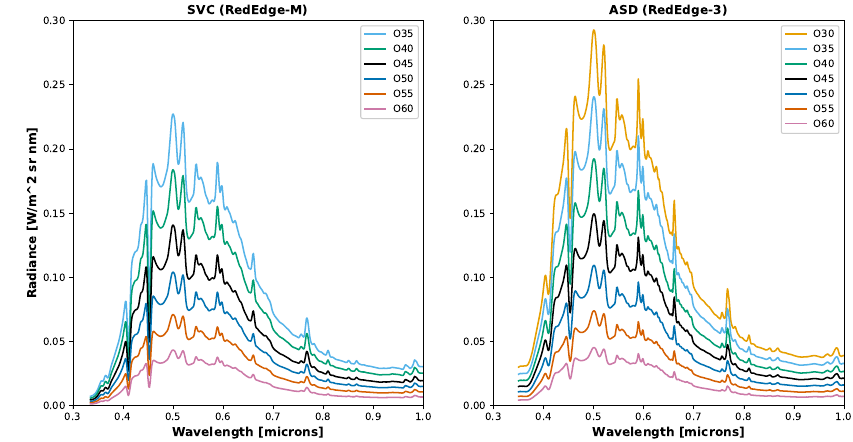
Figure 6. Example integrating sphere radiances. ( Left ) SVC radiances collected and used for calibrating the RedEdge-M sensor. ( Right ) ASD radiances collected and used for calibrating the RedEdge-3 sensor. As expected, the measured spectra decreased in magnitude as the PEL’s aperture was